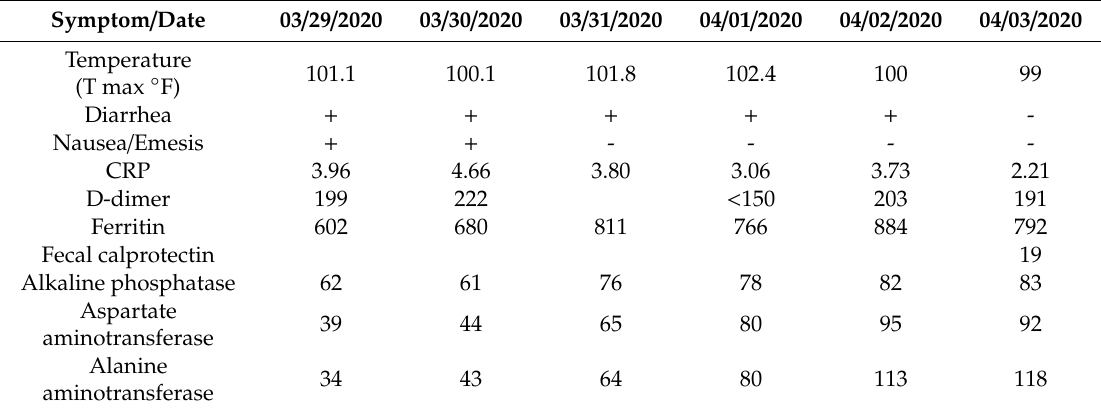
Table 1. Vital / laboratory values / Table 1. Vital/laboratory values/trend.